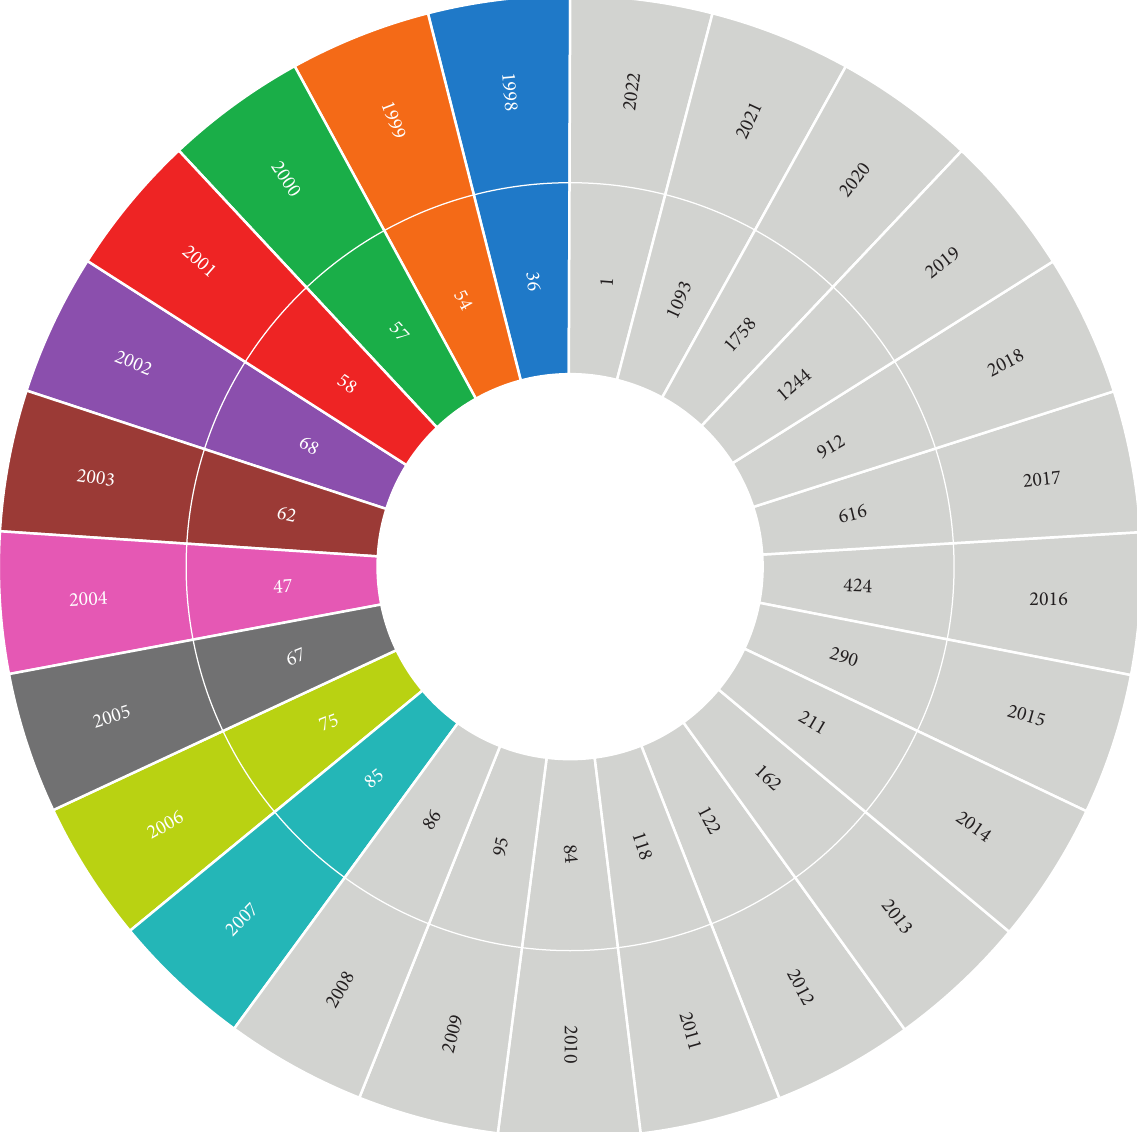
Figure 2: Years of publications and the number of articles